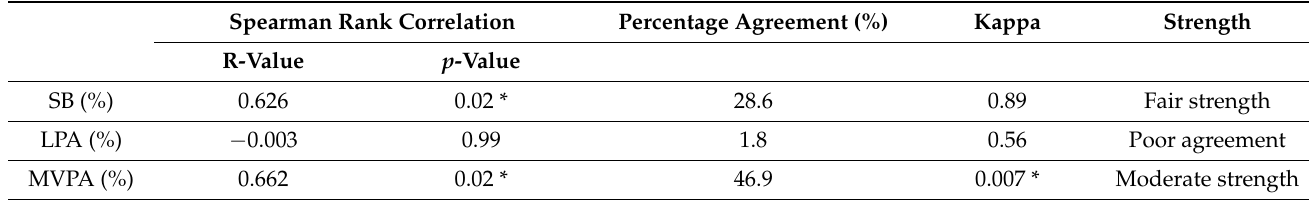
Table 3. Spearman rank-order correlations and kappa statistics to assess tracking over 1